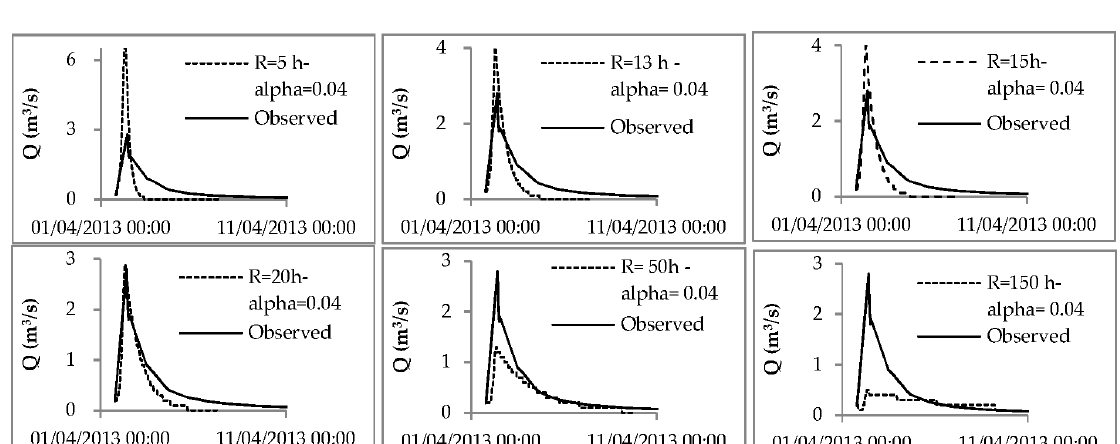
Figure 4. Lumped-based rainfall–runoff modeling performed by changing the R value to 13, 15, 20, 50, and 150 h. The simulations highlighted the model’s sensitivity to R value variation. The R values used for the runoff simulation fell within the value ranges calculated for the 20 events. In the first simulation, where R = 5 h, the simulated hydrograph was representative of direct runoff according to the physical interpretation of the storage time; here, the fastest response of the system occurred. The peak discharge was two orders of magnitude greater than the observed values, and the recession limb exhibited a high slope according to the behavior of the considered runoff process. Among the available simulations using R values falling within the range of a fast return flow (R = 13, R = 15, and R = 20), the simulation with R = 20 h appeared to provide better prediction modeling for both the peak discharge evaluation and the first part of the falling limb (fast and direct flow). The simulated de- layed recession limb (R = 150 h), instead, was underestimated here with respect to the observed limbs because the applied R value was not high enough to also consider the deep component. According to [29] and [32], this R value indicates that the runoff component is generated from water released by means of soil pipe flows. The simulation with R = 50 and 150 h confirmed that these times indicated a fast and delayed return flow. To test the model’s reliability, mass balance hydrograph separation was performed following the procedure proposed in [29], using only the EC as tracers, along with field hydro-geomorphologic monitoring. The authors presented new mass balance models (MBMs) that, using a cascade approach, are able to separate a hydrograph into more than two runoff components and related mechanisms. Figure 5 compares the resulting rainfall– runoff model (RRM) derived by the HEC-HMS application and the runoff components derived by the mass balance model (MBM) using the end-members defined in [29] (Table 2).